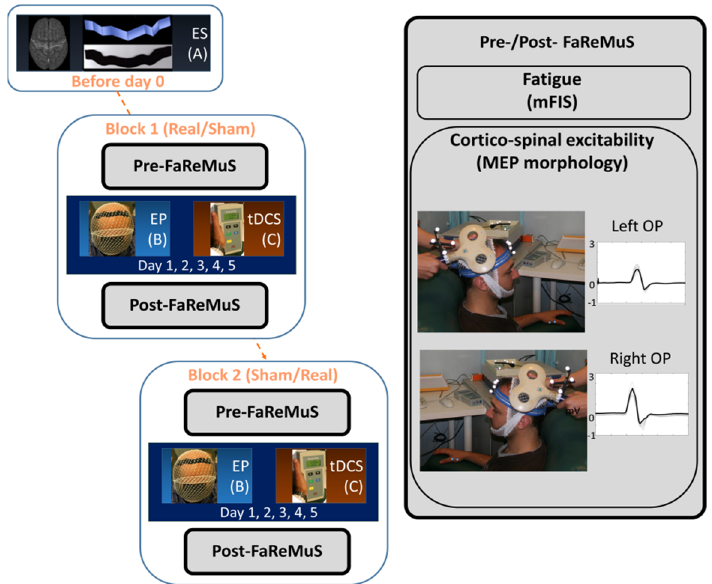
Figure 1. Experimental procedure in each fatigued person with MS undergoing Faremus treatment. Left from top : Individual brain MRI-based personalized electrode shaping [ES (A)] performed once before tDCS sessions. In blocks 1 and 2 (equal, but the 5 − day stimulation is either real or sham based on random assignment), after the data collection (pre-Faremus), the electrode positioning [EP, (B)] is executed before each 15 min stimulation [tDCS, (C)] of each of the 5 days of treatment. On the day of the last tDCS, we performed the data collection (post-Faremus). Right : Data collection (pre − and post − Faremus) includes the fatigue level assessment (modified fatigue impact scale, mFIS) and the collection of left/right opponens pollicis (OP) motor-evoked potential (MEP) by TMS, used for corticospinal tract excitability and inter-side homology